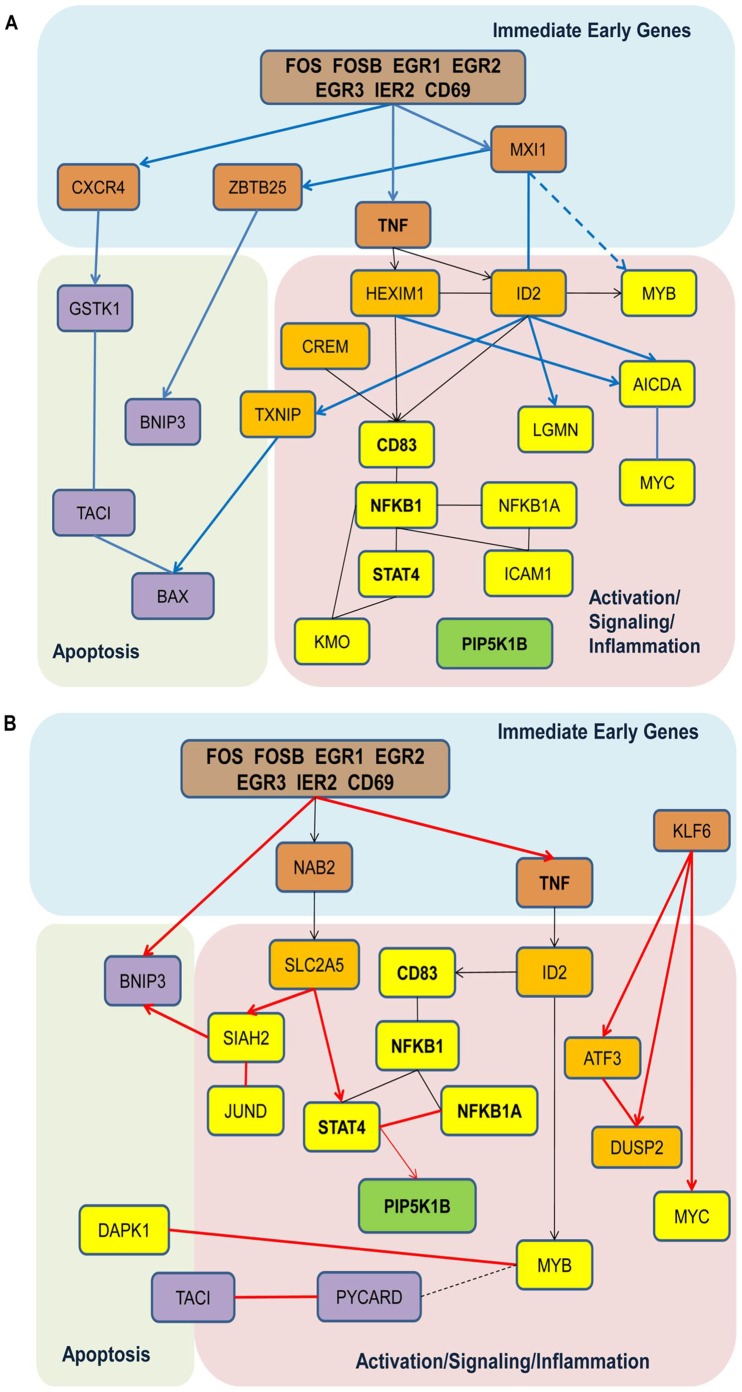
Dynamic gene networks in normal and SLE patient B cells.Unique dynamic gene networks of the examined (A) normal (n = 2) and (B) hyperresponsive B (n = 2) cells are shown. Genes that appear in both the normal and hyperresponsive B cells are in bold.